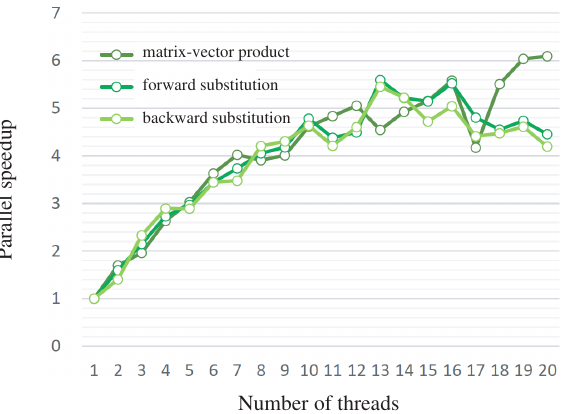
Figure 13. Parallel acceleration of each component for the 51 × 51 × 52 mesh.